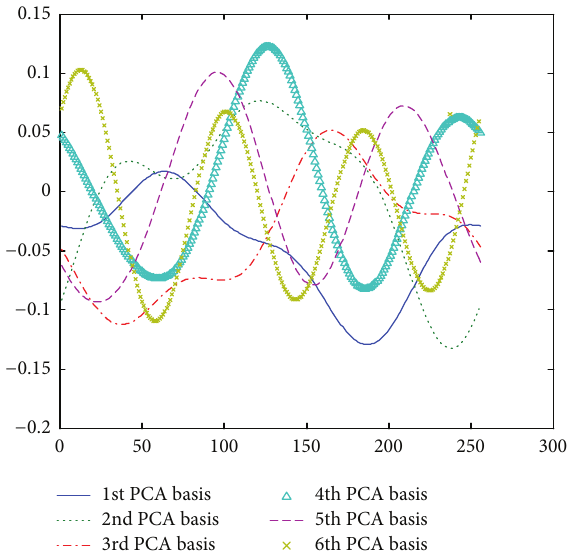
Figure 8: PCA bases of approximated LFE contours with 𝑚 value being 3.